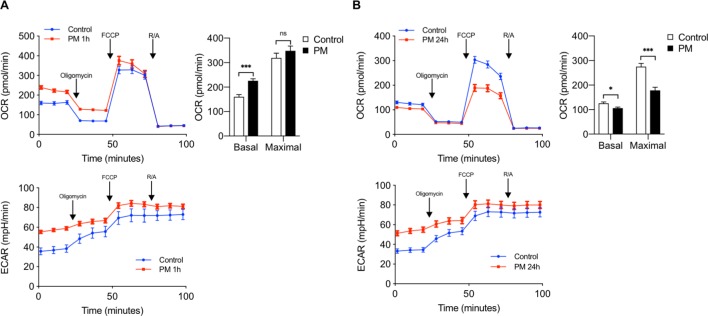
The effect of PM on mitochondrial oxygen consumption is time dependent.(A) We performed a mitochondrial stress test to measure OCR and ECAR in BMDMs at (A) 1 hour or (B) 24 hours following treatment with PM (20 μg/cm2) or control vehicle control. Oligomycin (ATP synthase inhibitor), FCCP (uncoupler), and rotenone/antimycin A (R/A) (complex I/III inhibitors) were injected sequentially. Basal OCR was acutely increased at 1 hour, which is before the induction of ACOD1 protein and production of itaconate. In contrast, both basal and maximal OCR decreased at 24 hours after PM treatment, when ACOD1 protein and itaconate levels are high (n = 8). ECAR was increased with PM at both timepoints. Significance was determined using two-tailed unpaired student’s t-test, *p<0.05, **p<0.01, ***p<0.001.